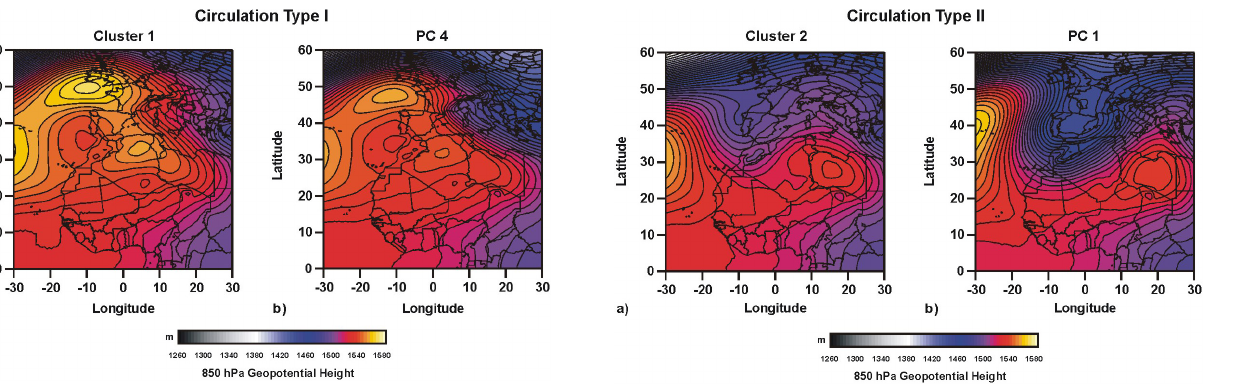
Figure 3. Composite 850hPa geopotential height (m) representing circulation type II leading to ADO over the western Mediterranean